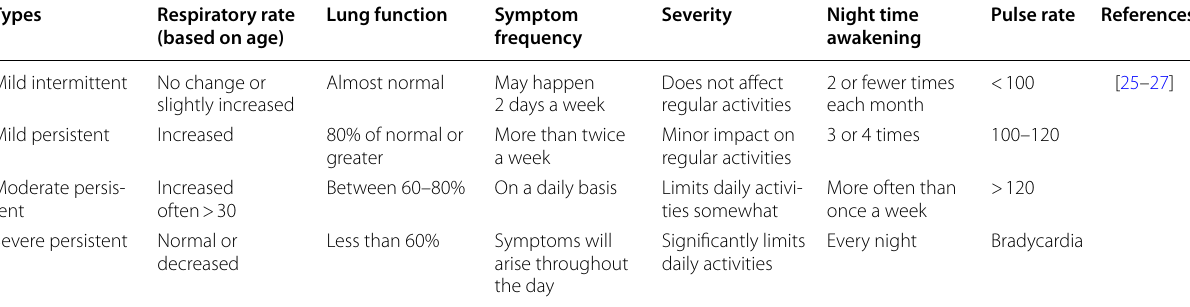
Table 2 Correlation between asthma types and respiratory system function Types